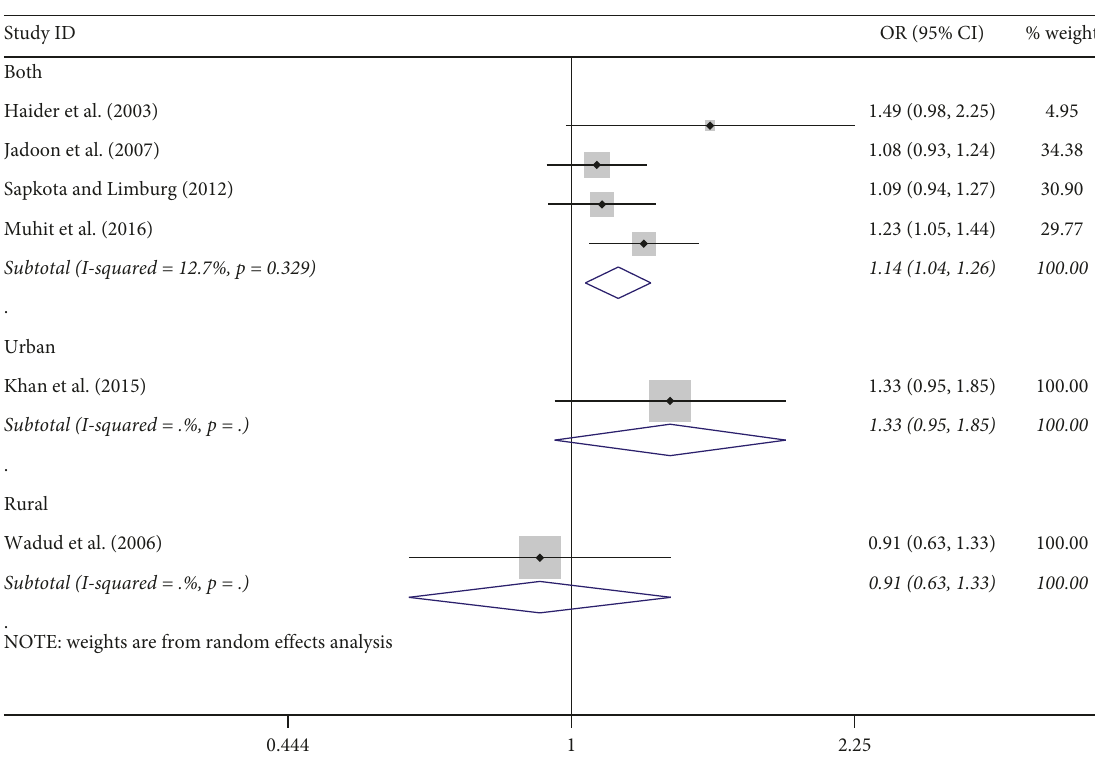
Figure 10: Subgroup analysis of CSC by location on a person basis at visual < 6/18 level. CSC � cataract surgical coverage; OR � odds ratio; CI � confidence